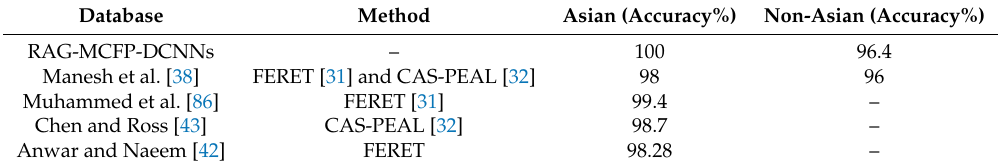
Table 6. Comparison between proposed method and related works on race